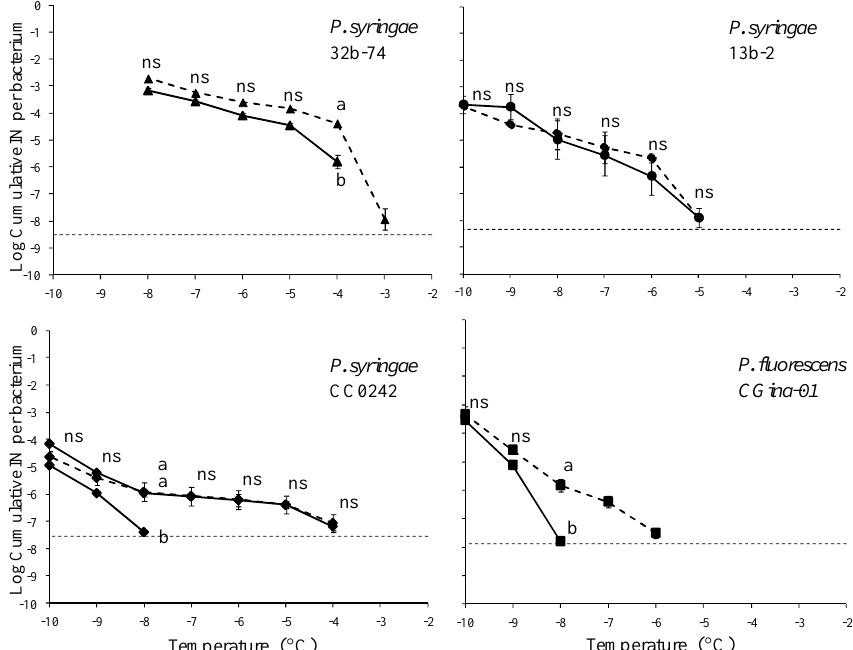
Fig. 3. Ice nucleation spectra of Pseudomonas strains exposed to synthetic gases with (solid line) and without (dotted line) NO 2 and O 3 . The horizontal line corresponds to the lower limit of detectable activity depending on the initial bacterial concentration of each experiment. Symbols are as in Fig. 1. Each symbol corresponds to the mean value of 4 replicates except for P. syringae CC0242 that was exposed to gases with NO 2 and O 3 , where symbols correspond to the mean value of 2 replicates. At each temperature, values associated with different letters are significantly different ( p < 0.05) based on Tukey’s test. ns: no significant treatment effect. Errors bars are standard errors ( n = 4, except for P. syringae CC0242 where n = 2).